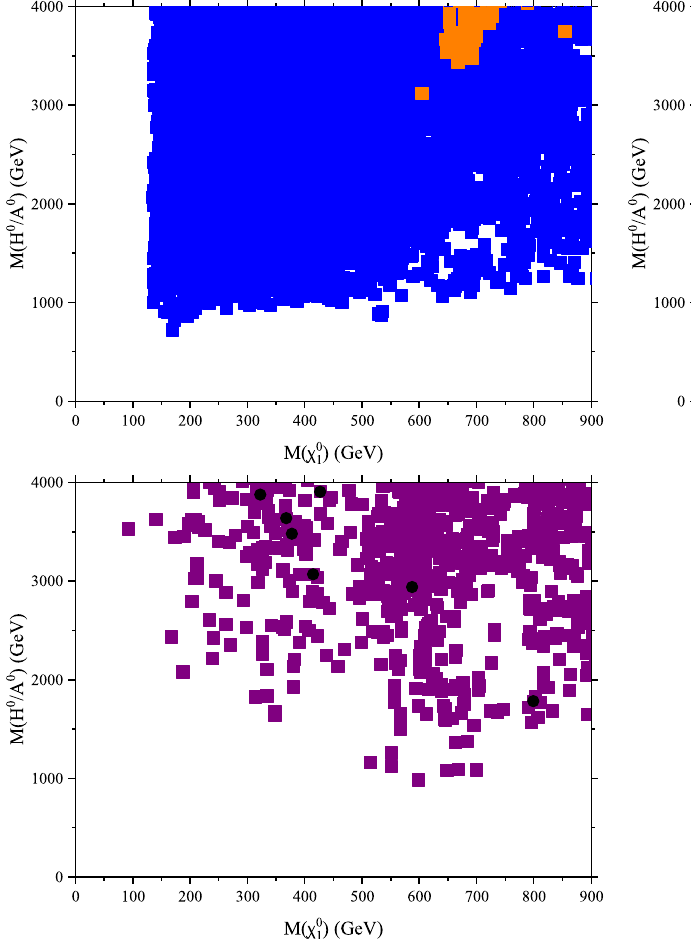
Fig. 3 Heavy neutral and pseudoscalar SUSY Higgs mass M ( H 0 / A 0 ) in this work, in addition to rare decay and current LHC SUSY search ) for the four regions constraints. The round black dots represent those points that can also as a function of the lightest neutralino mass M ( (cid:2) χ 0 1 satisfy the recent 2018 Planck Collaboration satellite relic density mea- of the model space we study in this work. The Higgs Funnel region surements of (cid:9) h 2 = 0 . 120 ± 0 . 001 can be observed in the upper right plot space. All points plot satisfy the light Higgs boson mass and relic density observations we outlined